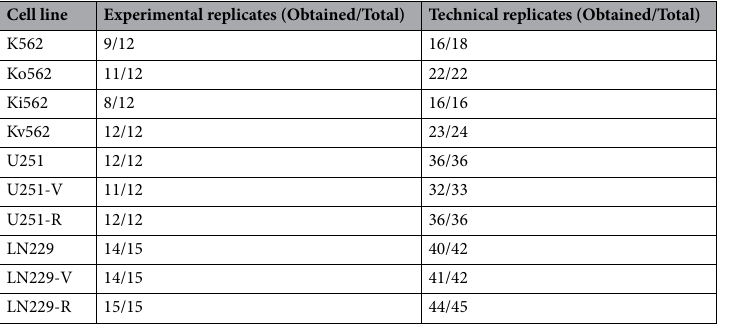
Table 1. Detailed information about experimental and technical replicates obtained with all the cell lines under